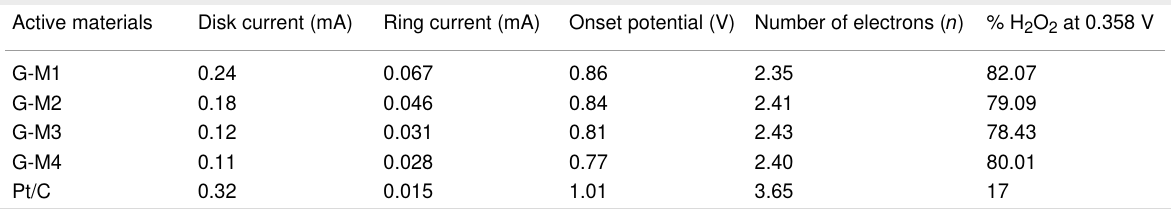
Table 1: The RRDE experiment electrochemical parameters obtained at 0.358 V (vs RHE, from Figure 4a). Active